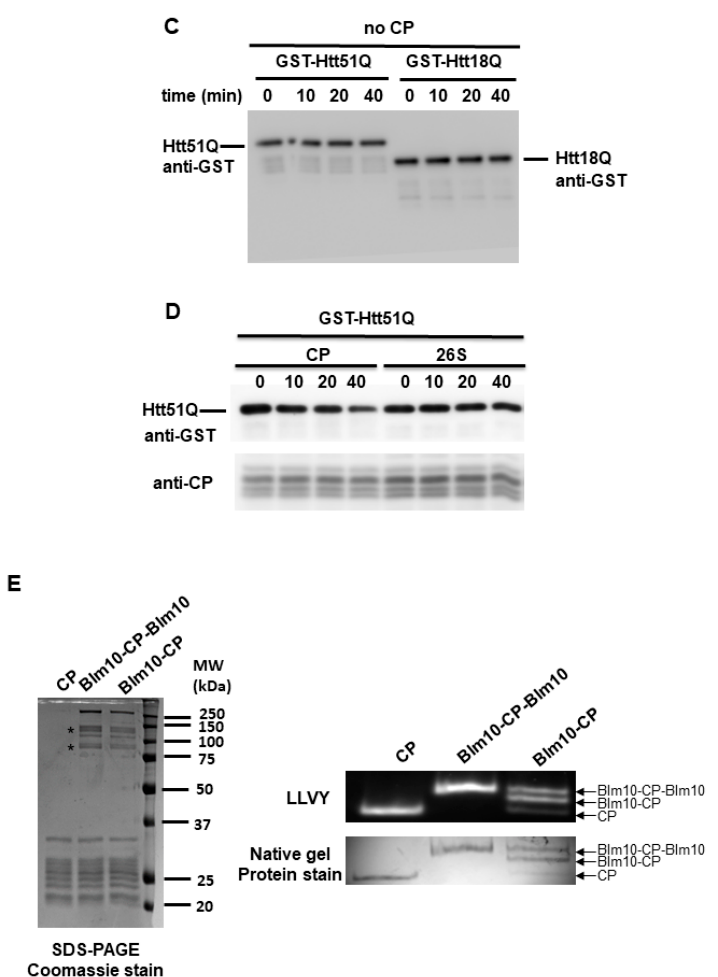
Figure 6. The degradation of soluble GST-Htt51Q and GST-Htt18Q is accelerated by Blm10 in vitro. ( A , B ) Uncleaved GST-Htt51Q and GST-Htt18Q were incubated with equal molar amounts of purified CP or Blm10-CP. (Left panels) Aliquots were taken at the times indicated and separated by SDS-PAGE. Htt51Q and Htt18Q were detected by immunoblotting with a GST-specific antibody. (Right panels) Quantification of degradation of soluble GST-Htt51Q and GST-Htt18Q by the proteasome. Data are shown as mean ± SD of three independent experiments. Statistical analysis was accomplished by ANOVA test using GraphPad Prism v. 8.2.1 software (* indicates p < 0.05; ** indicates p < 0.01; **** indicates p < 0.0001), * indicates statistical comparison of CP complexes with Q18 or Q51 to N-Htt samples without CP complexes, # indicates statistical comparison between CP complexes (CP and Blm10-CP) with Q18 or Q51. ### indicates p < 0.001; #### indicates p < 0.0001, ns indicates not significant). ( C ) GST-Htt51Q and GST-Htt18Q are not degraded and remain stable in the absence